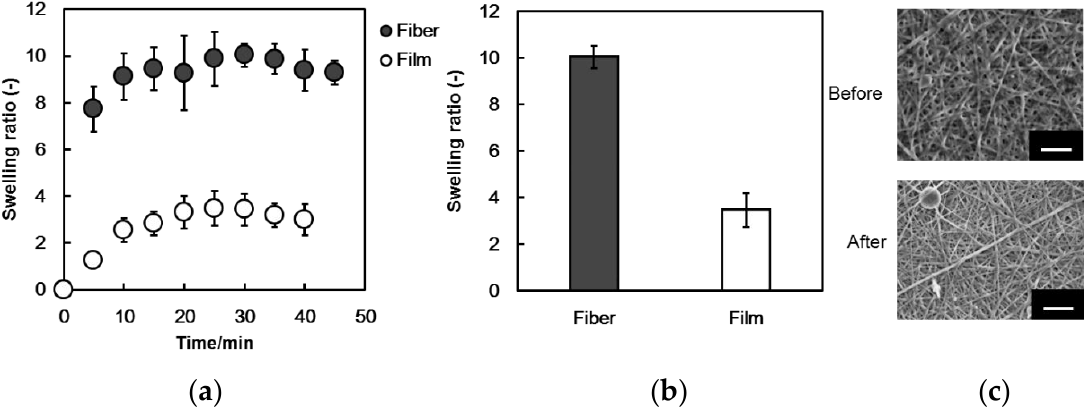
Figure 8. ( a , b ) Water absorption of PSA nanofiber meshes (closed circle) and PSA film (open circle) in mouse blood. Data are expressed in mean ± SD (n = 3); ( c ) SEM images of the PSA nanofibers before (upper images) and after (lower images) the water absorption test in blood. Scale bar: 10 μm.